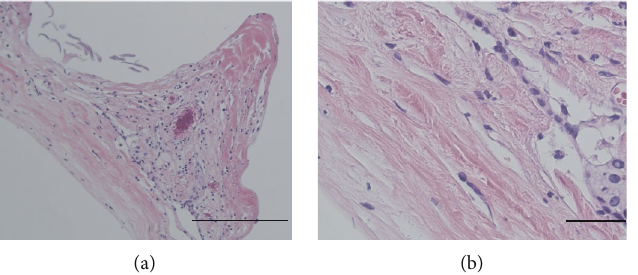
Figure 6: Histopathological fi ndings. The hematoxylin and eosin staining showed synovial cells in the fi brocartilaginous capsule: (a) lower magni fi cation; (b) higher magni fi cation, bar: 100 μ